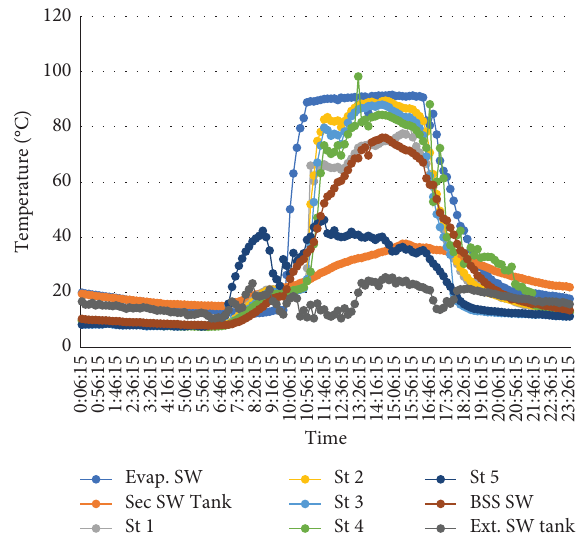
Figure 10: SW temperature curves for the 29 th of September